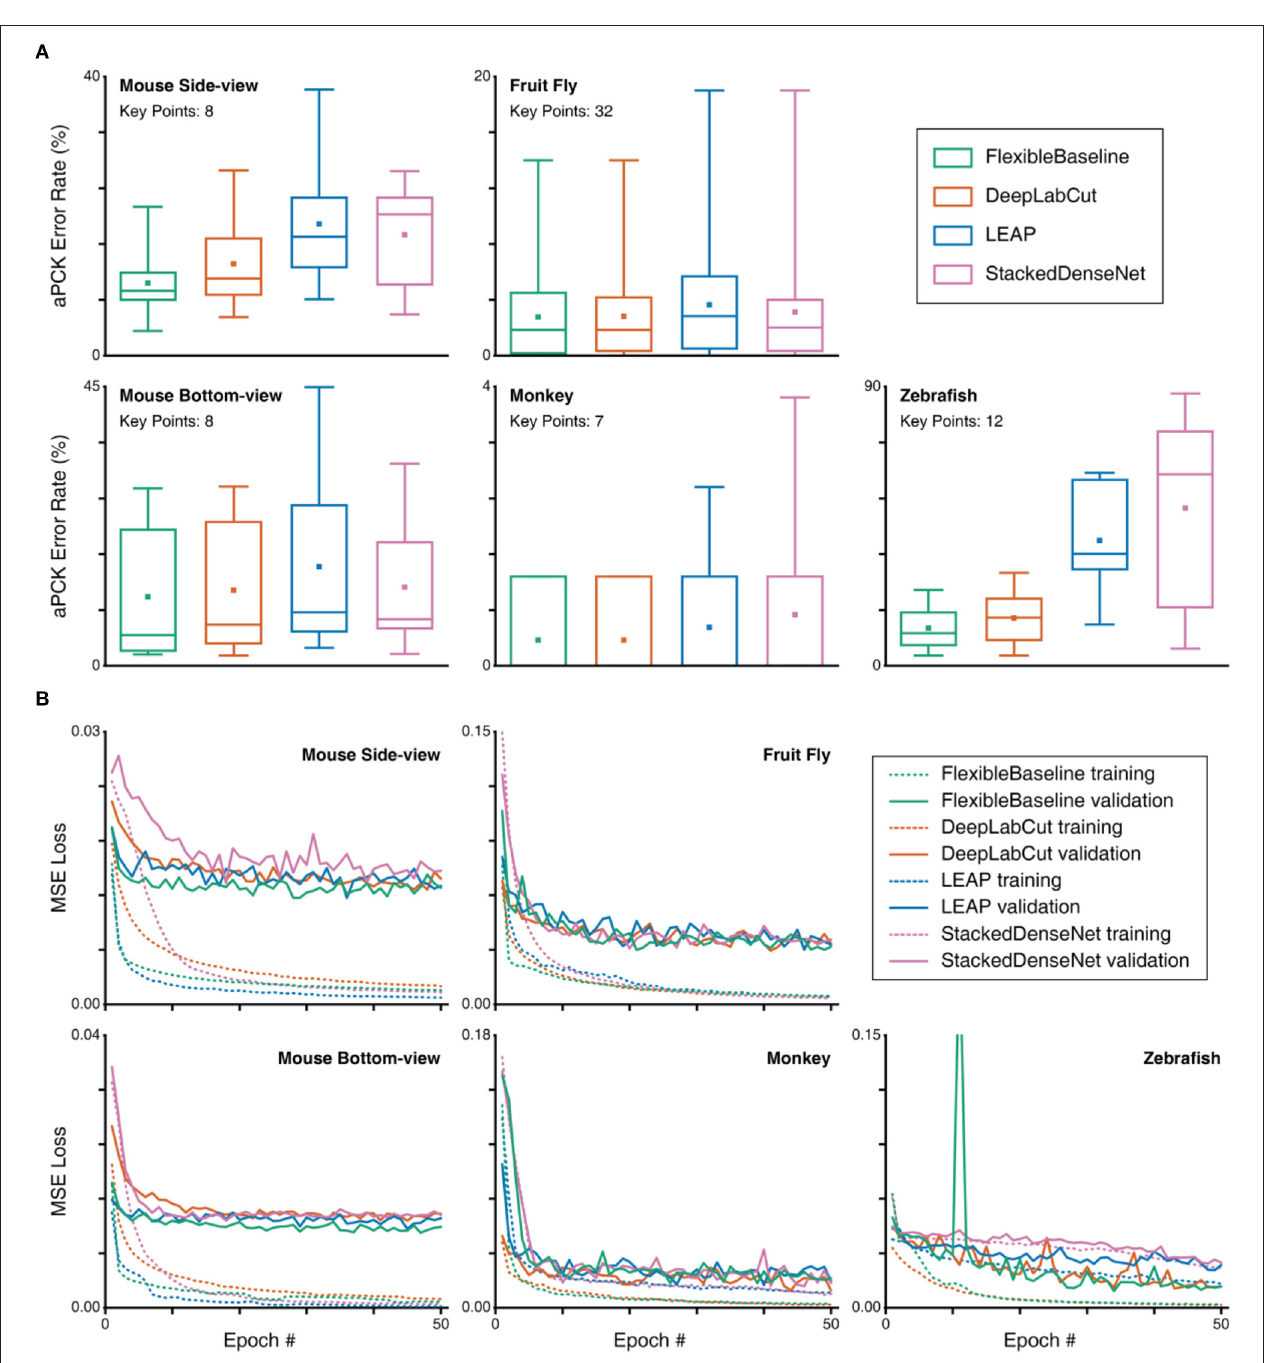
FIGURE 6 | Comparison of aPCK error rates and MSE loss curves on different datasets. (A) Test set prediction error rates represented in box plots. Box plot specified with minimum, first quartile, median, third quartile, and maximum; the small square in each box represents the mean. Note that some monkey results do not show whiskers (parameters of variability), due to nearly perfect predictions. Refer to Figure 4A caption for details of the data represented in the box plot. The number of frames in the test set of each animal are specified in Supplementary Table 2 , and the number of key points for each animal is indicated on the plot. (B) MSE training and validation loss; it should be noted that the peak in zebrafish reflects the fact that the optimizer landed in a poor spot early in the training process. through the OpticalFlow model. Thus, the better